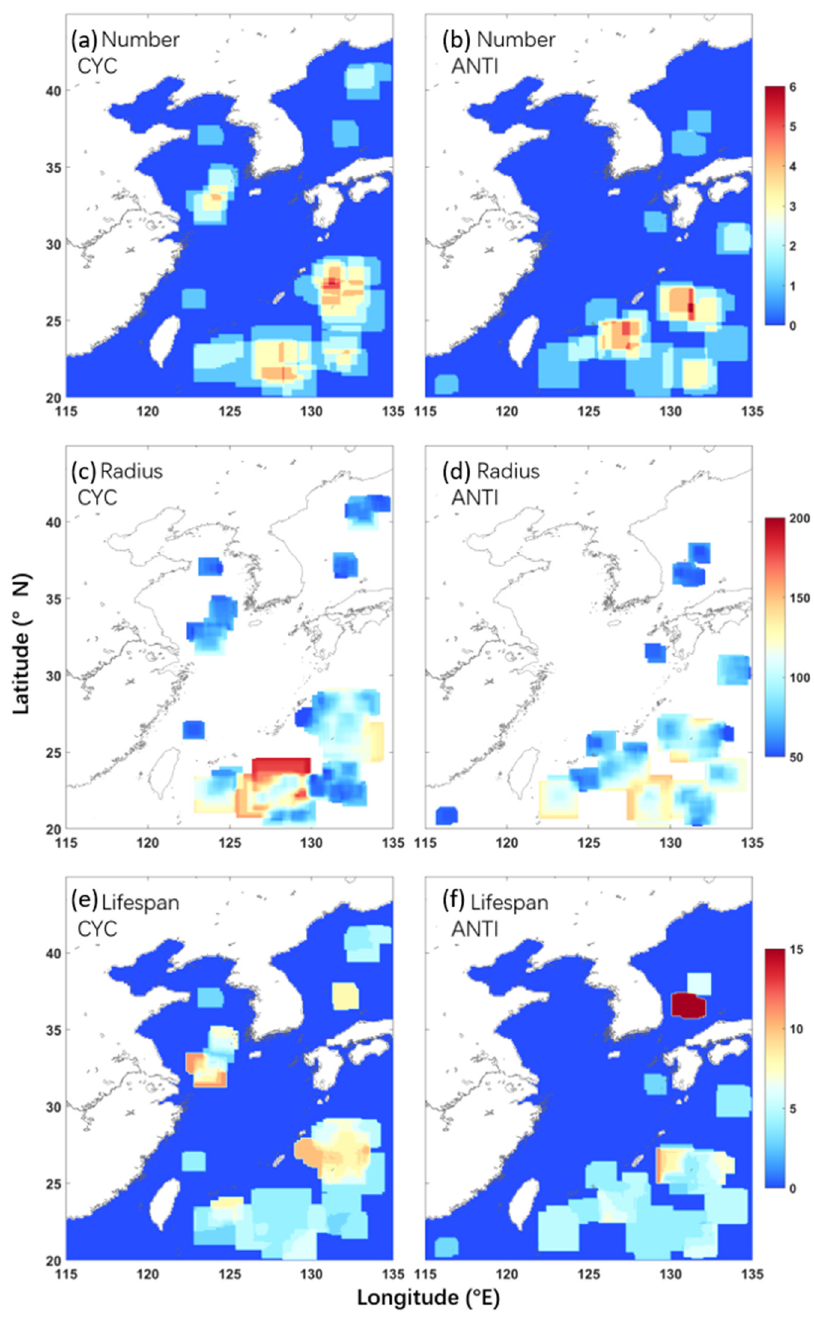
Figure 13. Distributions of ( a ) cyclonic and ( b ) anticyclonic eddy number. ( c ) Mean cyclonic and ( d ) anticyclonic eddy radius (km). ( e ) Cyclonic and ( f ) anticyclonic eddy lifespan (week) detected in 2-DVar. The eddy number (eddy radius, eddy lifespan) in each grid (0.08 degree) is the total number of times (mean radius, mean lifespan) an eddy is detected in that grid.